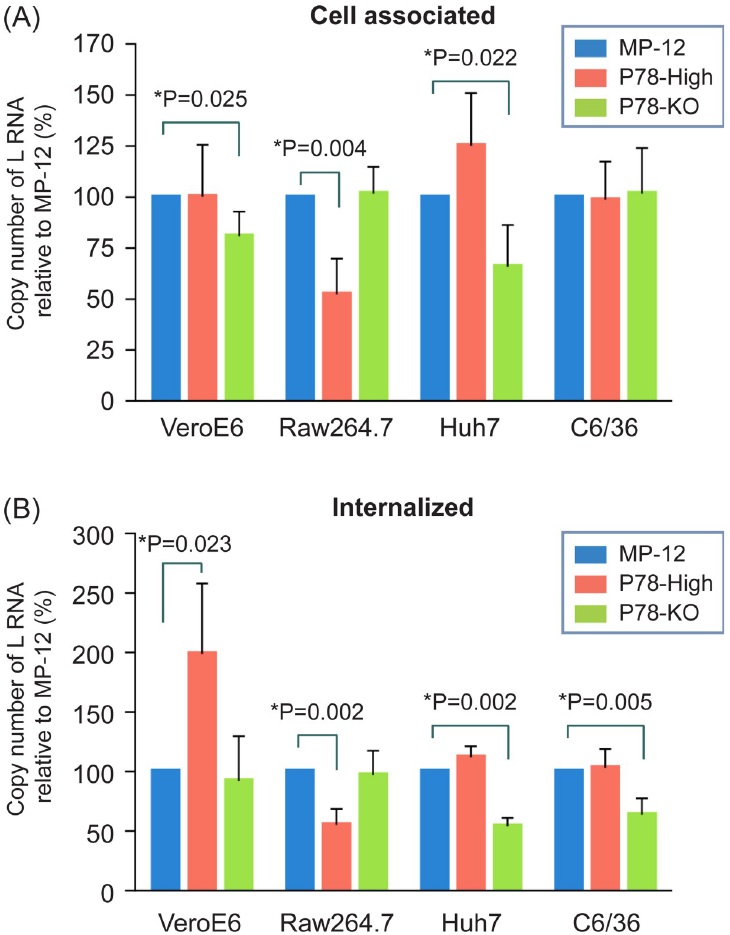
Fig 5. Efficiency of virus binding (A) and internalization (B) of MP-12 and its variants in Vero E6, Raw 264.7, Huh7, and C6/36 cells. (A) Cells were inoculated with the indicated viruses and incubated for 1 h at 4˚C on ice. After removal of unadsorbed viruses, total RNA was extracted from the cells and subjected to RT-qPCR for detection of genomic sense L RNA. Viral RNA was also extracted from inoculum virus as an input sample and subjected to RT-qPCR. Copy number of L RNA in experimental samples were normalized by copy number of L RNA in input samples. (B) Cells were inoculated with the indicated viruses and incubated for 1 h at 37˚C or 28˚C for C6/36 cells. Cells were further treated with pronase to remove cell-associated extracellular virus. Total RNA was extracted from the cells and subjected to RT-qPCR for detection of viral L RNA. Data was normalized to input samples as described in (A). The difference between MP-12 and its variants was assessed by unpaired t-test. The data represents the mean values ± standard deviation from three independent